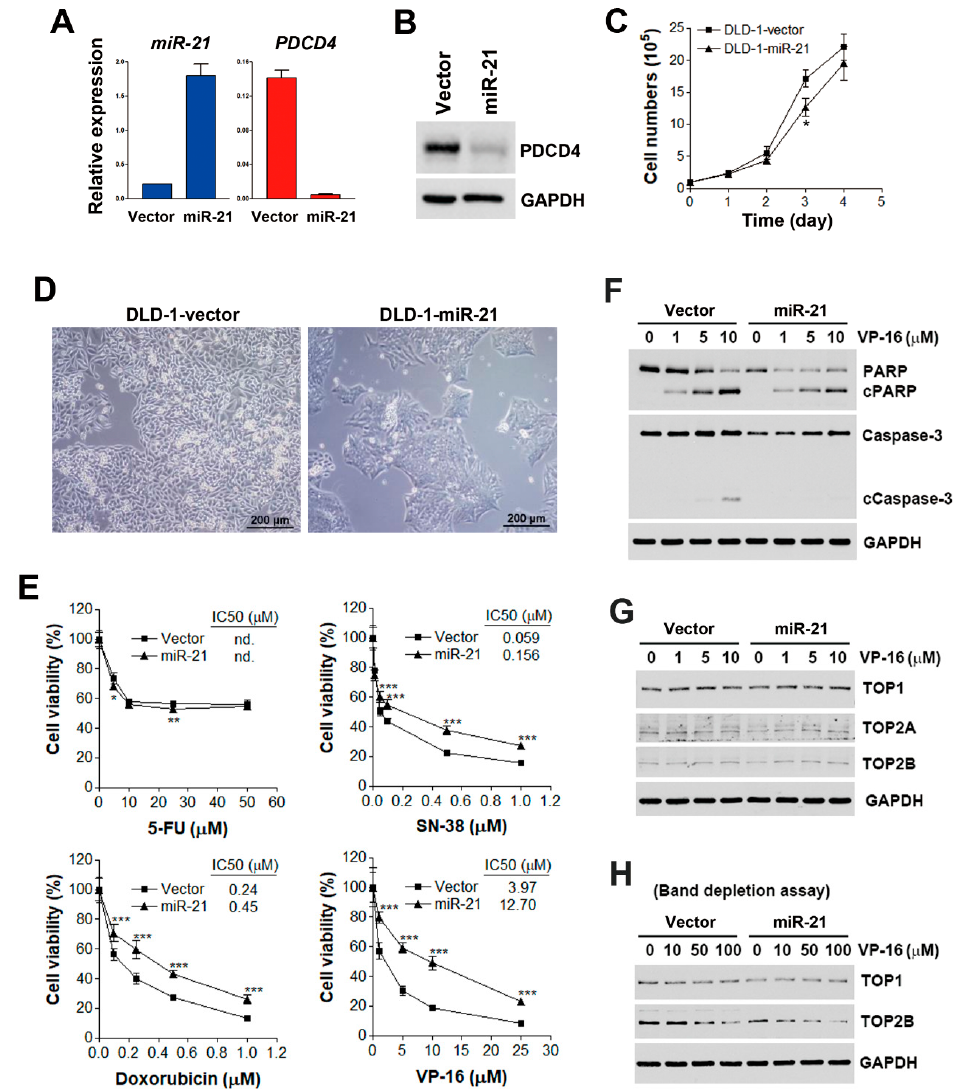
Figure 2. E ff ect of miR-21 overexpression on chemosensitivity. ( A ) mRNA expression of miR-21 and programmed cell death 4 (PDCD4) in corresponding vector-overexpressing DLD-1 (DLD-1-vector) and miR-21-overexpressing DLD-1 (DLD-1-miR-21) cells were analyzed by qPCR. ( B ) Protein expressions of PDCD4 in DLD-1-vector and DLD-1-miR-21 cells were analyzed by Western blot analysis. ( C ) Growth rates of DLD-1-vector and DLD-1-miR-21 cells were measured by cell counts at approximately 1 to 4 days. p < 0.05 (*) indicates significant di ff erences between DLD-1-miR-21 and DLD-1-vector cells. ( D ) Cell morphology was observed under bright-field microscopy. ( E ) DLD-1-vector and DLD-1-miR-21 cells were treated with various doses of 5-fluorouracil (5-FU), SN-38, doxorubicin, and VP-16 for 72 h. Cell viability was analyzed by an 3-(4,5-dimethylthiazol-2-yl)-2,5-diphenyl tetrazolium bromide (MTT) assay. p < 0.05 (*), p < 0.01 (**), or p < 0.001 (***) indicates significant di ff erences between DLD-1-miR-21 and DLD-1-vector cells. n.d., not determined. ( F ) DLD-1-vector and DLD-1-miR-21 cells were treated with various doses of VP-16 for 48 h. Whole-cell lysates were prepared and subjected to a Western blot analysis. ( G ) DLD-1-vector and DLD-1-miR-21 cells were treated with various doses of VP-16 for 24 h. Whole-cell lysates were prepared and subjected to a Western blot analysis. ( H ) DLD-1-vector and DLD-1-miR-21 cells were treated with various doses of VP-16 for 1 h. A band-depletion assay was performed as described in “Materials and